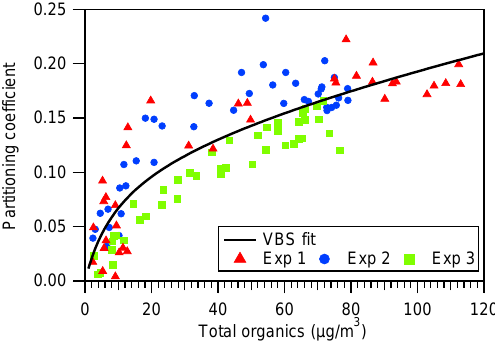
Figure 5. Volatility basis set fit from this work shown with data from Exps. 1, 2, and